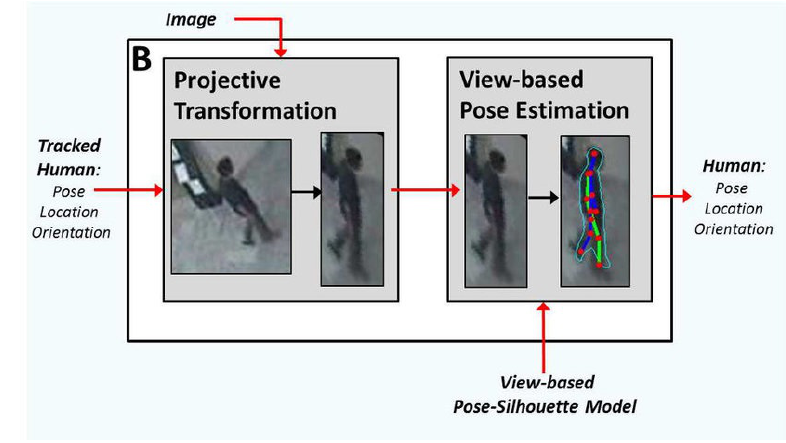
Fig. 6 Method flow